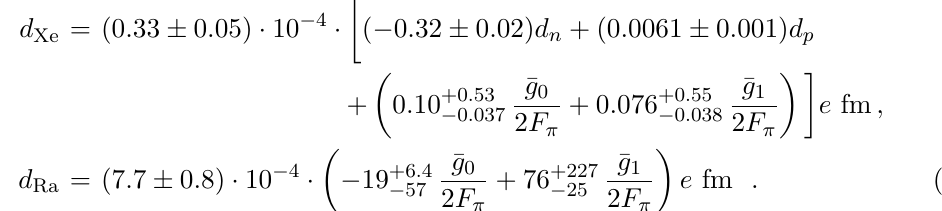
d = (0 : 33 (cid:6) 0 : 05) (cid:1) 10 (cid:0) 4 Xe